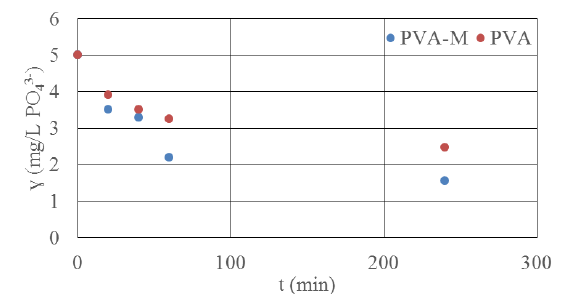
Figure 6. Phosphate concentrations